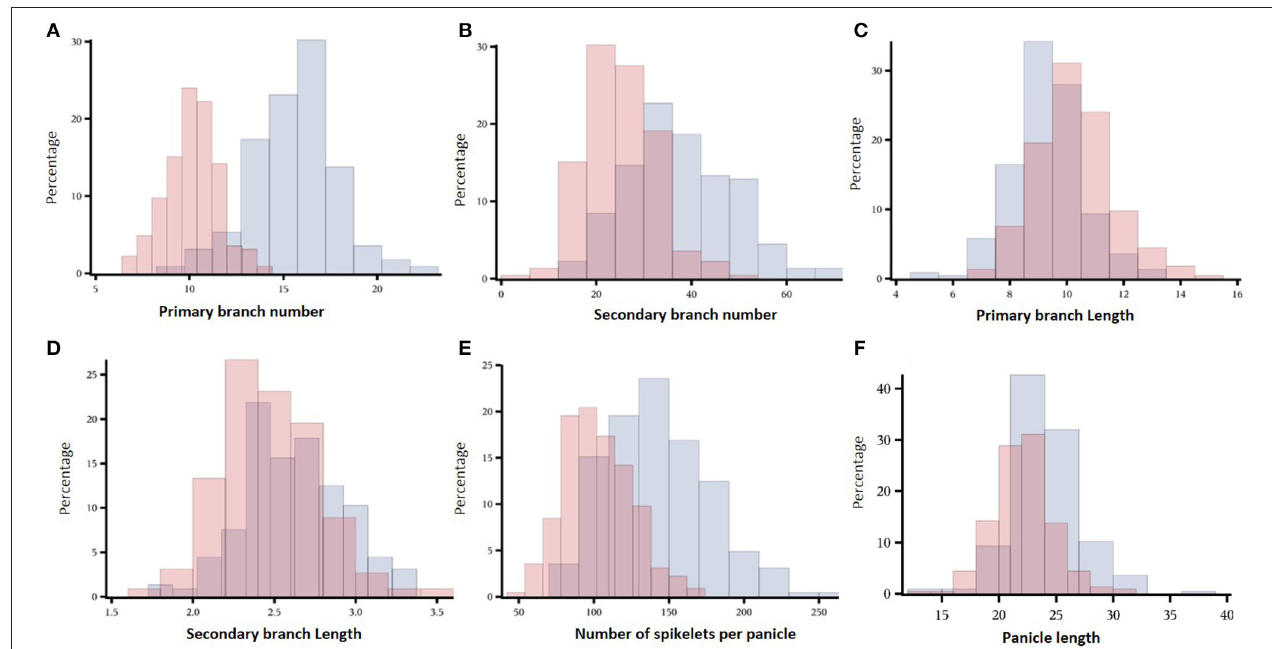
FIGURE 1 | Histograms of the distribution for panicle architecture related traits in both experiments. In blue and red are values for Exp1-TR and Exp2-DRS respectively. The percentage of individuals for each class is presented in the y-axis. (A) Primary branch number, (B) Secondary branch number, (C) Primary branch length, (D) Secondary branch length, (E) Number of spikelets per panicle, (F) Panicle length.